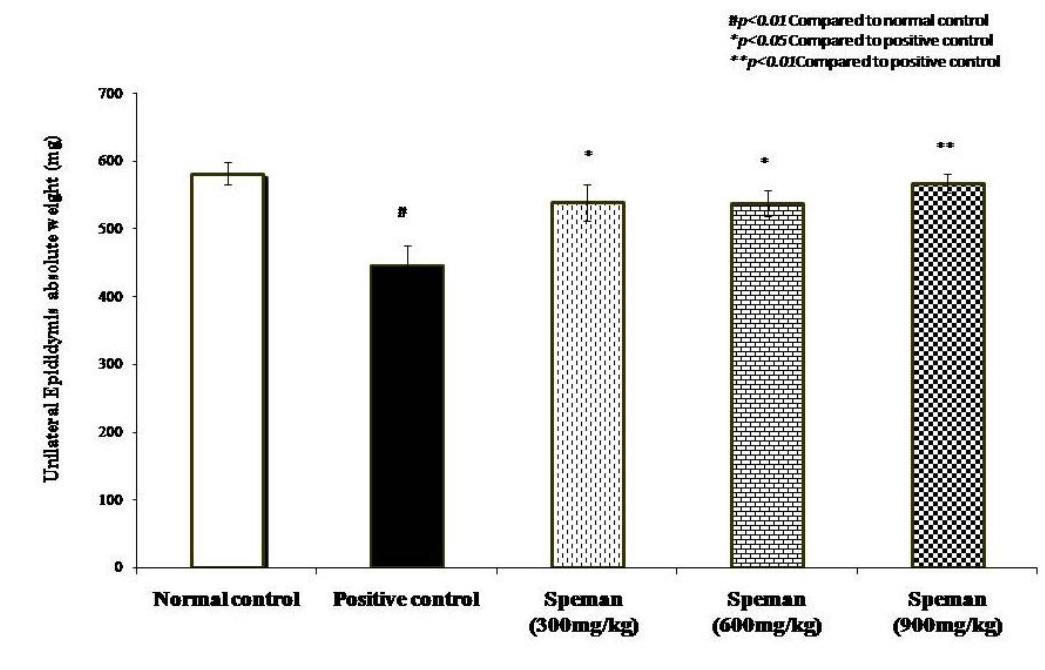
Figure 3: Effect of Speman ® on the absolute weight of unilateral epididymis in an experimental model of CP-induced oligospermia in